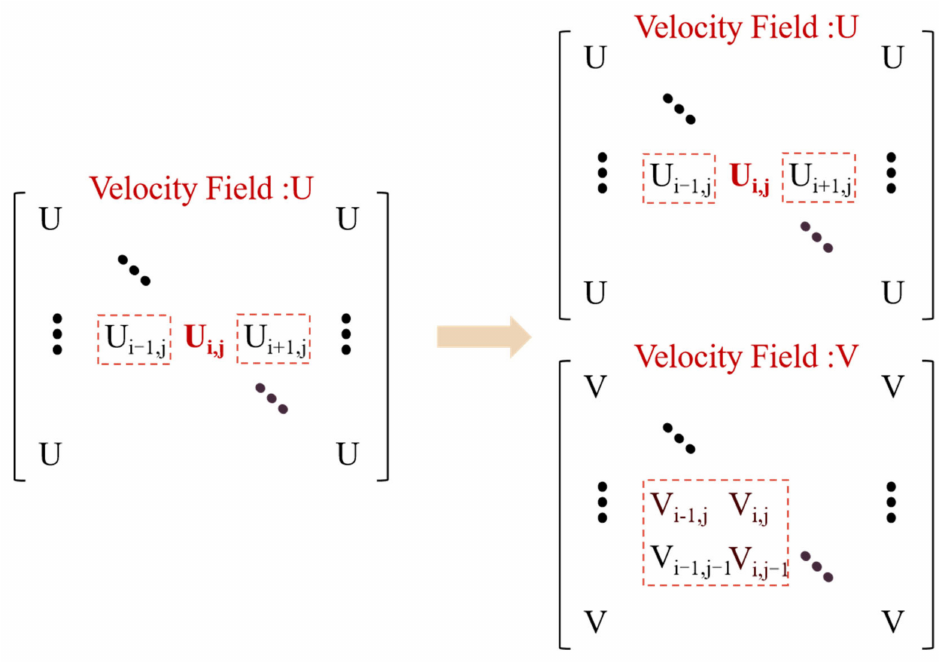
Figure 4. Fractional‑order versus integer‑order special step advance